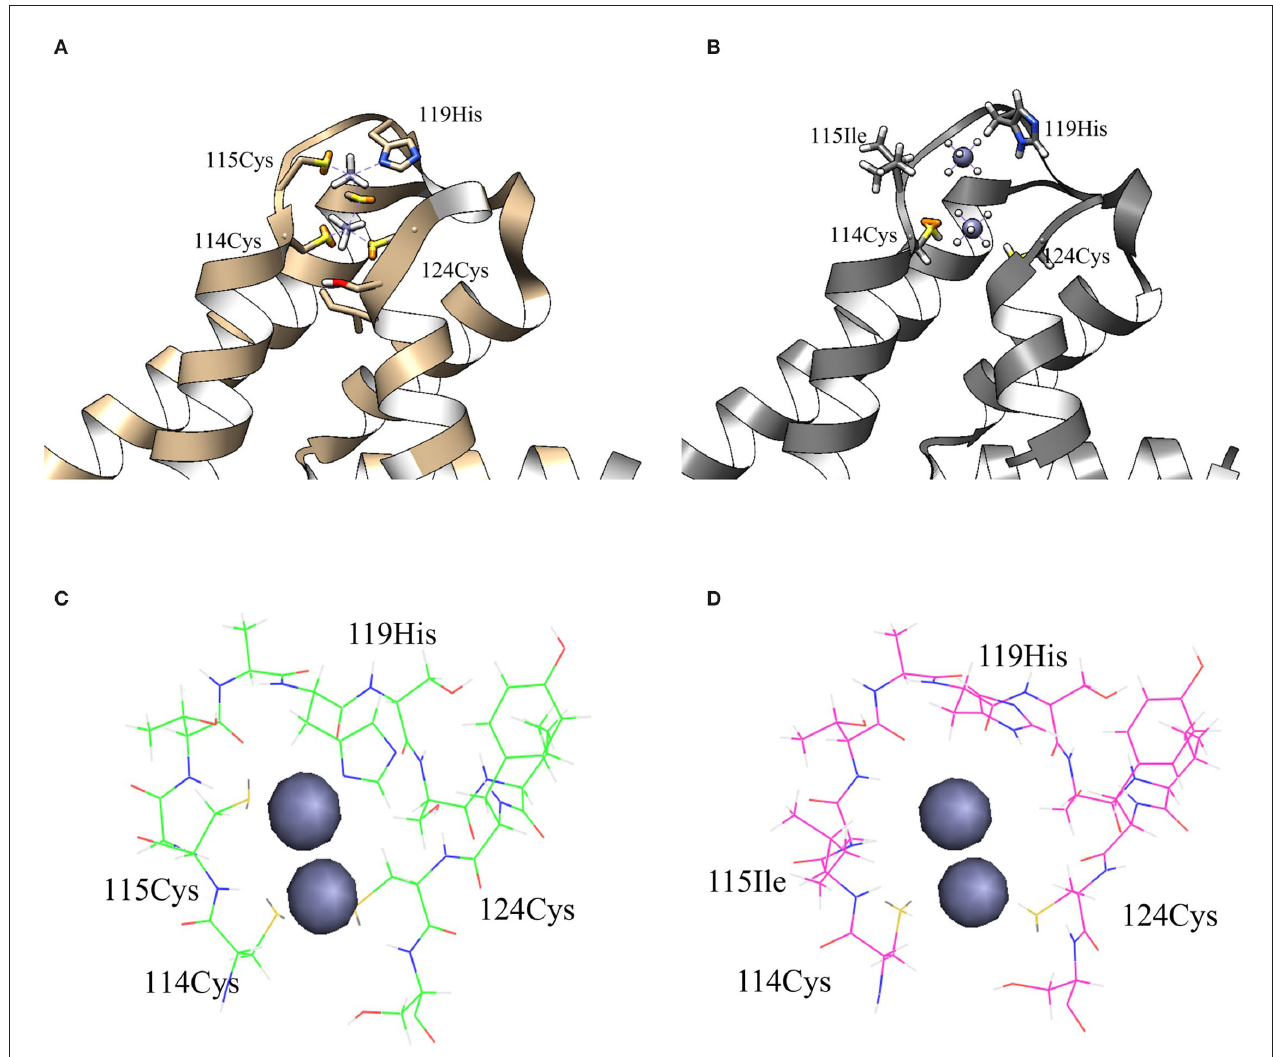
FIGURE 7 | The structures of metal-binding loop regions for ZntR WT and C115I. The structures of MBLs for ZntR WT (A) and C115I (B) with stick representation of 4 residues interacting with zinc ions. The stick representation of amino acids consisted of MBLs for ZntR WT (C) and ZntR C115I (D) . The zinc-binding sites of wild type (green) and mutant of C115I (magenta) are shown as the stick representation.